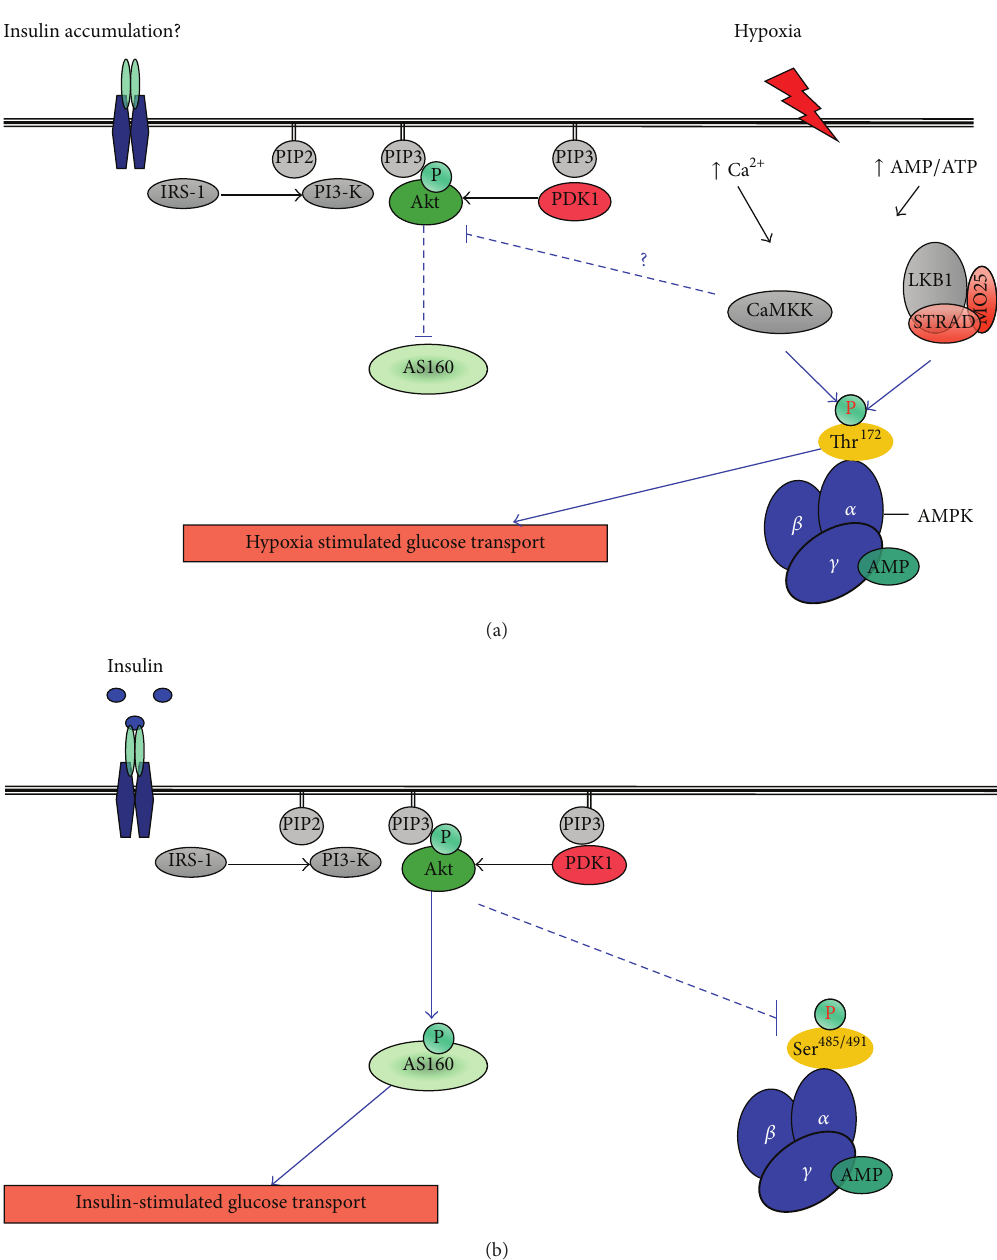
Figure 2: Proposed communication between hypoxia- and insulin-stimulated glucose transport mechanisms. (a) displays the proposed hypoxia-induced Ca 2+ /CaMKK inhibition on insulin signaling and insulin-stimulated glucose transport. Glucose transport is facilitated via an AMPK-dependent mechanism in response to hypoxia despite decreased Akt activity. (b) Glucose transport mechanisms in response to insulin. (b) also displays Akt mediated AMPK phosphorylation at Ser 485/491 [93] resulting in AMPK